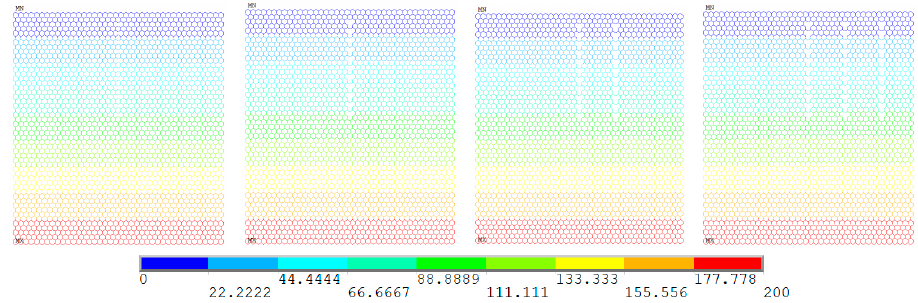
Figure 11. Temperatures of graphene with its heat source in armchair edges (The four figures are for the graphene sheets with generally increasing periodic vacancy defects).